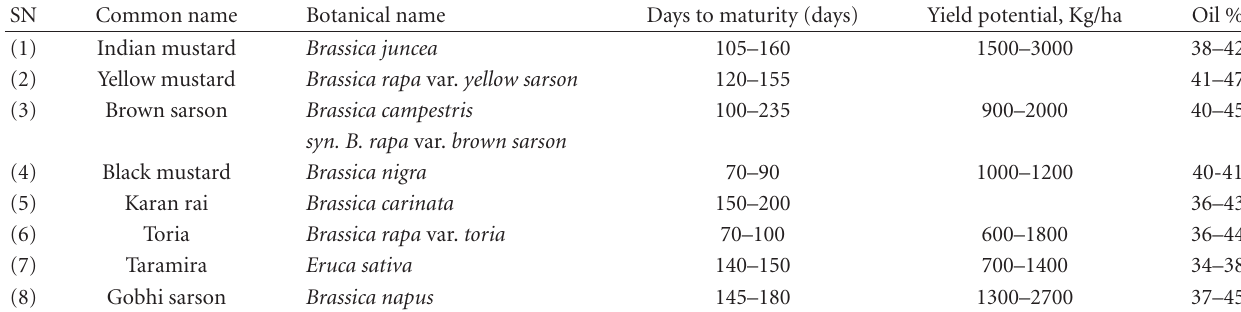
Table 1: Salient features of cultivated species of rapeseed-mustard (Cruciferous) group of